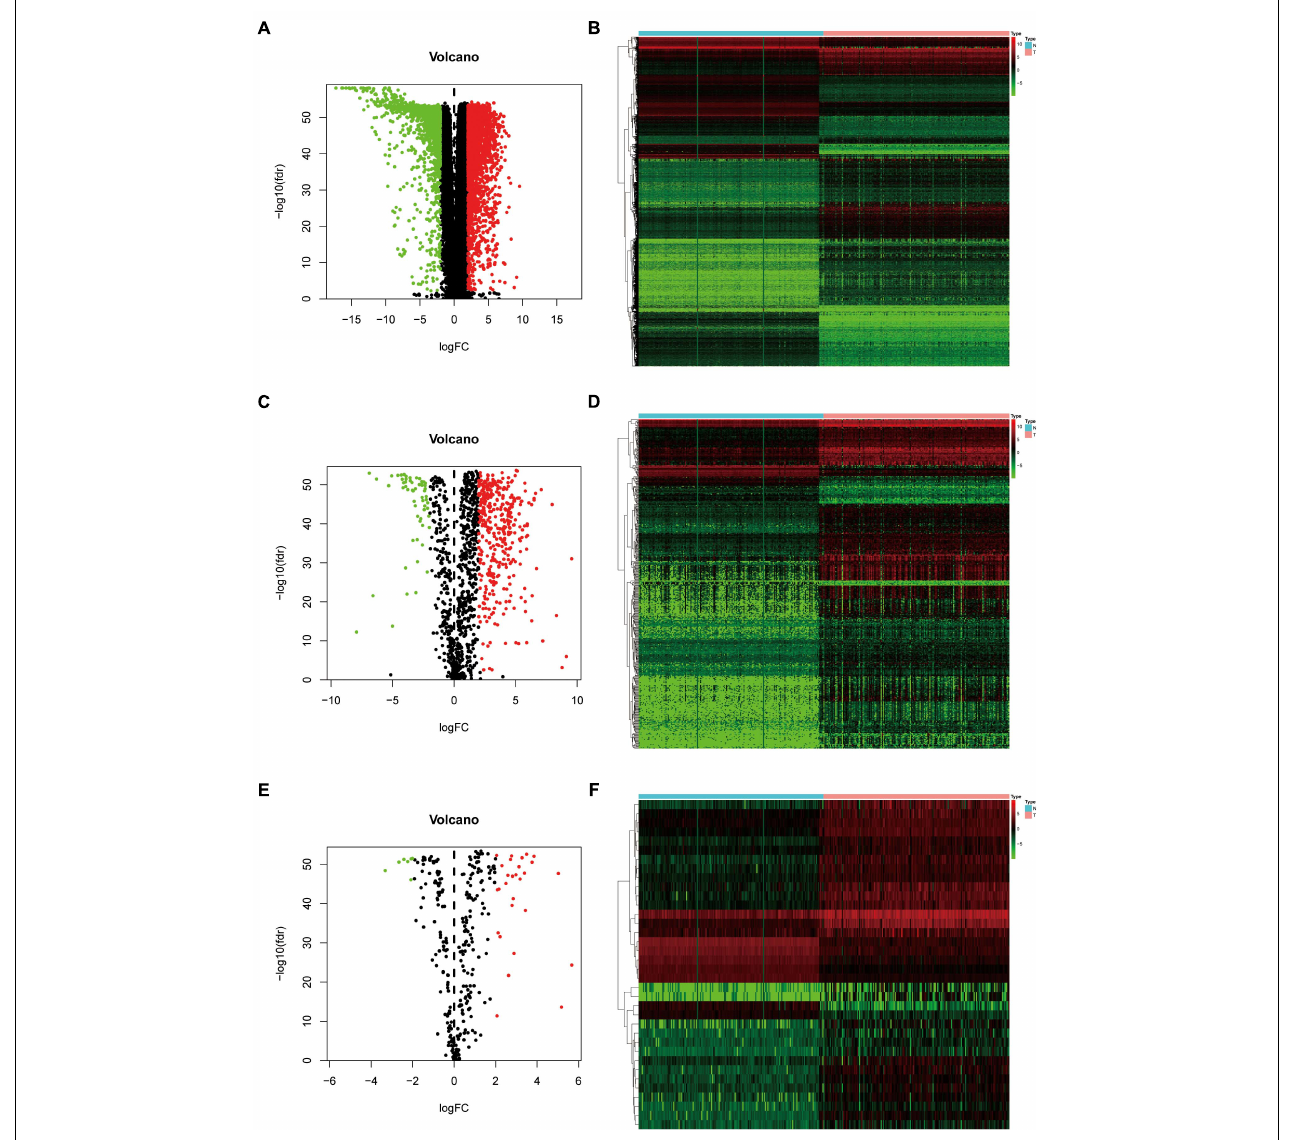
FIGURE 2 | Identification of differentially expressed genes (DEGs), immune-related genes (IRGs), and transcription factors (TFs) in Pancreatic adenocarcinoma (PAAD) vs . normal tissues. (A) Volcano plot revealing clusters of DEGs with upregulated and downregulated expression. (B) The distinction between DEG expression in tumor tissues and normal tissues revealed by a hierarchical clustering heatmap. (C) Volcano plot demonstrates clusters of differentially expressed immune-related genes (DEIRGs) with upregulated and downregulated expression. (D) Heatmap showing the distinction between expression of DEIRGs in tumor tissues and normal tissues. (E) Volcano plot showing clusters of differentially expressed transcription factors (DETFs) with upregulated and downregulated expression. (F) Discrimination between DETFs expression in tumor tissues and normal tissues revealed by a